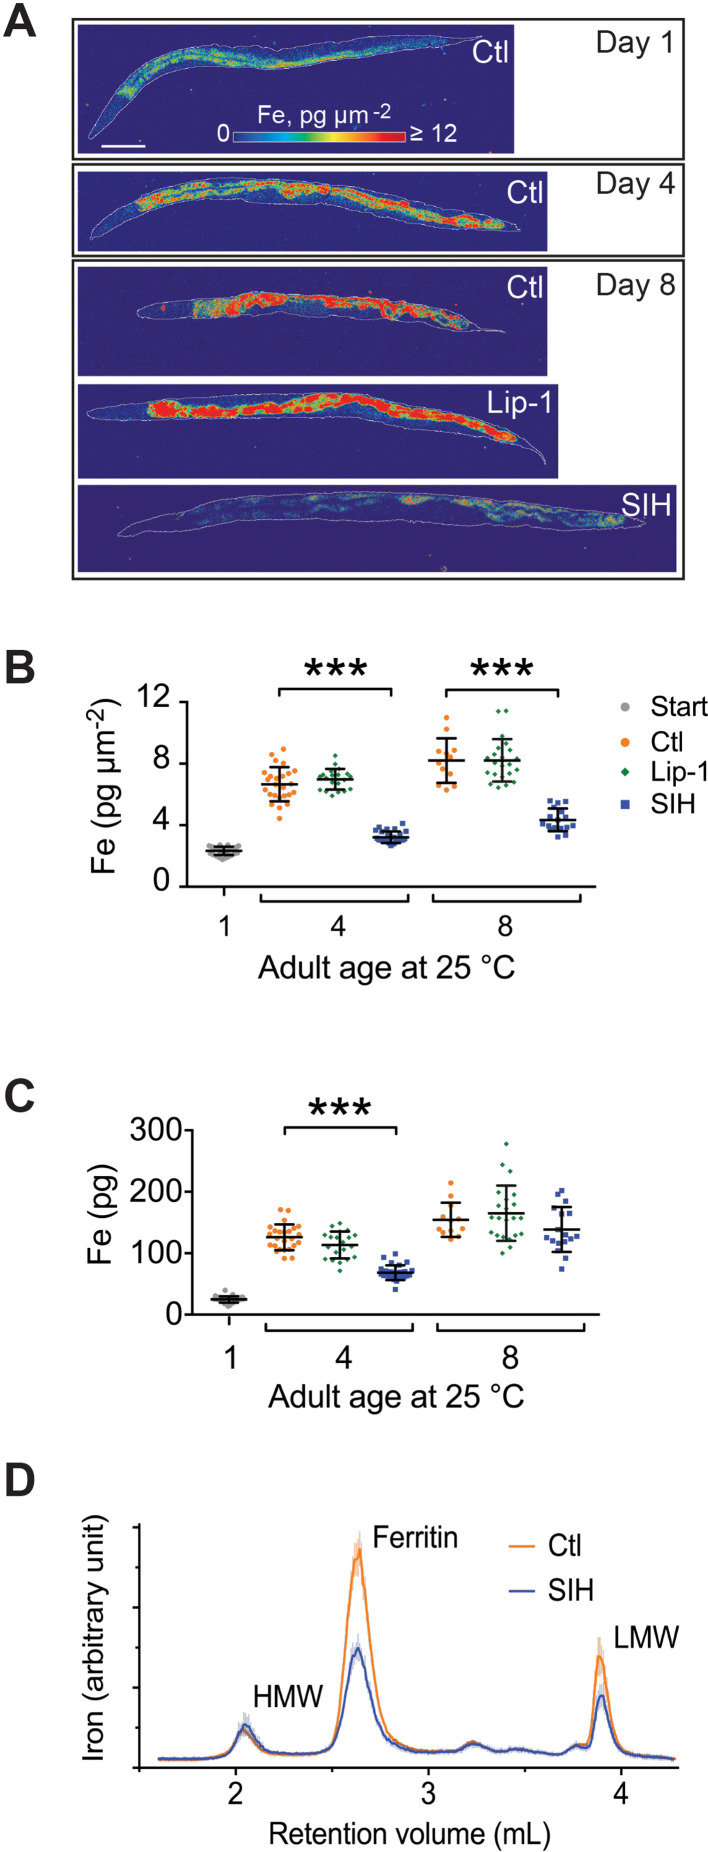
Effects of Lip-1 and SIH on iron levels and distribution in C. elegans.In all panels, vehicle control (0.5% v/v DMSO, Ctl) treated worms are shown in orange, Lip-1 treated (200 µM Lip-1) are green and SIH treated (250 µM SIH) are blue. (A) Representative X-ray fluorescence microscopy maps of tissue iron (Fe) reported as areal density (pg µm−2) for a first day adult (Day 1) and animals treated for four days (Day 4) and eight days (Day 8) with vehicle control (Ctl), Lip-1 or SIH at 25°C. Scale bar = 50 µm. (B) Plot of mean areal density for iron (pg µm−2) for all treatment cohorts aged at 25°C. The starting population (Day 1, vehicle control (0.5% v/v DMSO); Start)) is shown in grey. The control cohort (orange) shows an age related increase in total iron (as previously observed [James et al., 2015). The Lip-1 group (green) has similar iron levels across each age, whereas the SIH cohort (blue) has markedly less total iron (ANOVA: F(6,148)=171.3, p<0.0001; see Supplementary file 2 for sample summary and pair-wise comparisons). Each data point represents a value from a single C. elegans adult, with mean ± SD, ***p<0.001. (C) Plot of total body iron (pg) for treated C. elegans cohorts aged at 25°C. Each data point represents a value from a single C. elegans adult, with mean ± SD. All treatments have increased total iron across age with SIH-treated (blue) worms retaining significantly less iron than control (red) and Lip-1 (green) treated worms at Day 4 (ANOVA: F(6,148)=97.3, ***p<0.0001; see Supplementary file 2 for sample summary and pair-wise comparisons) (D) Native, size-exclusion chromatography of iron-macromolecular complexes from 10 day old adults treated with vehicle control (Ctl, shown in orange) or SIH-treated cohorts (shown in blue). The means ± SD, from three independent biological replicates, are plotted. The three major peaks include unaltered high molecular weight complexes (HMW,>1 MDa,~2.2 mL retention volume), ferritin bound iron (~2.7 mL retention volume; previously identified as FTN-2 [James et al., 2015]; area under the peak decreased by ~53% relative to Ctl) and low molecular weight iron complexes (LMW,<30 kDa,~3.9 mL retention volume, decreased ~47% relative to Ctl).Figure 3—source data 1.Data for XFM and mass spectrometry comparisons.